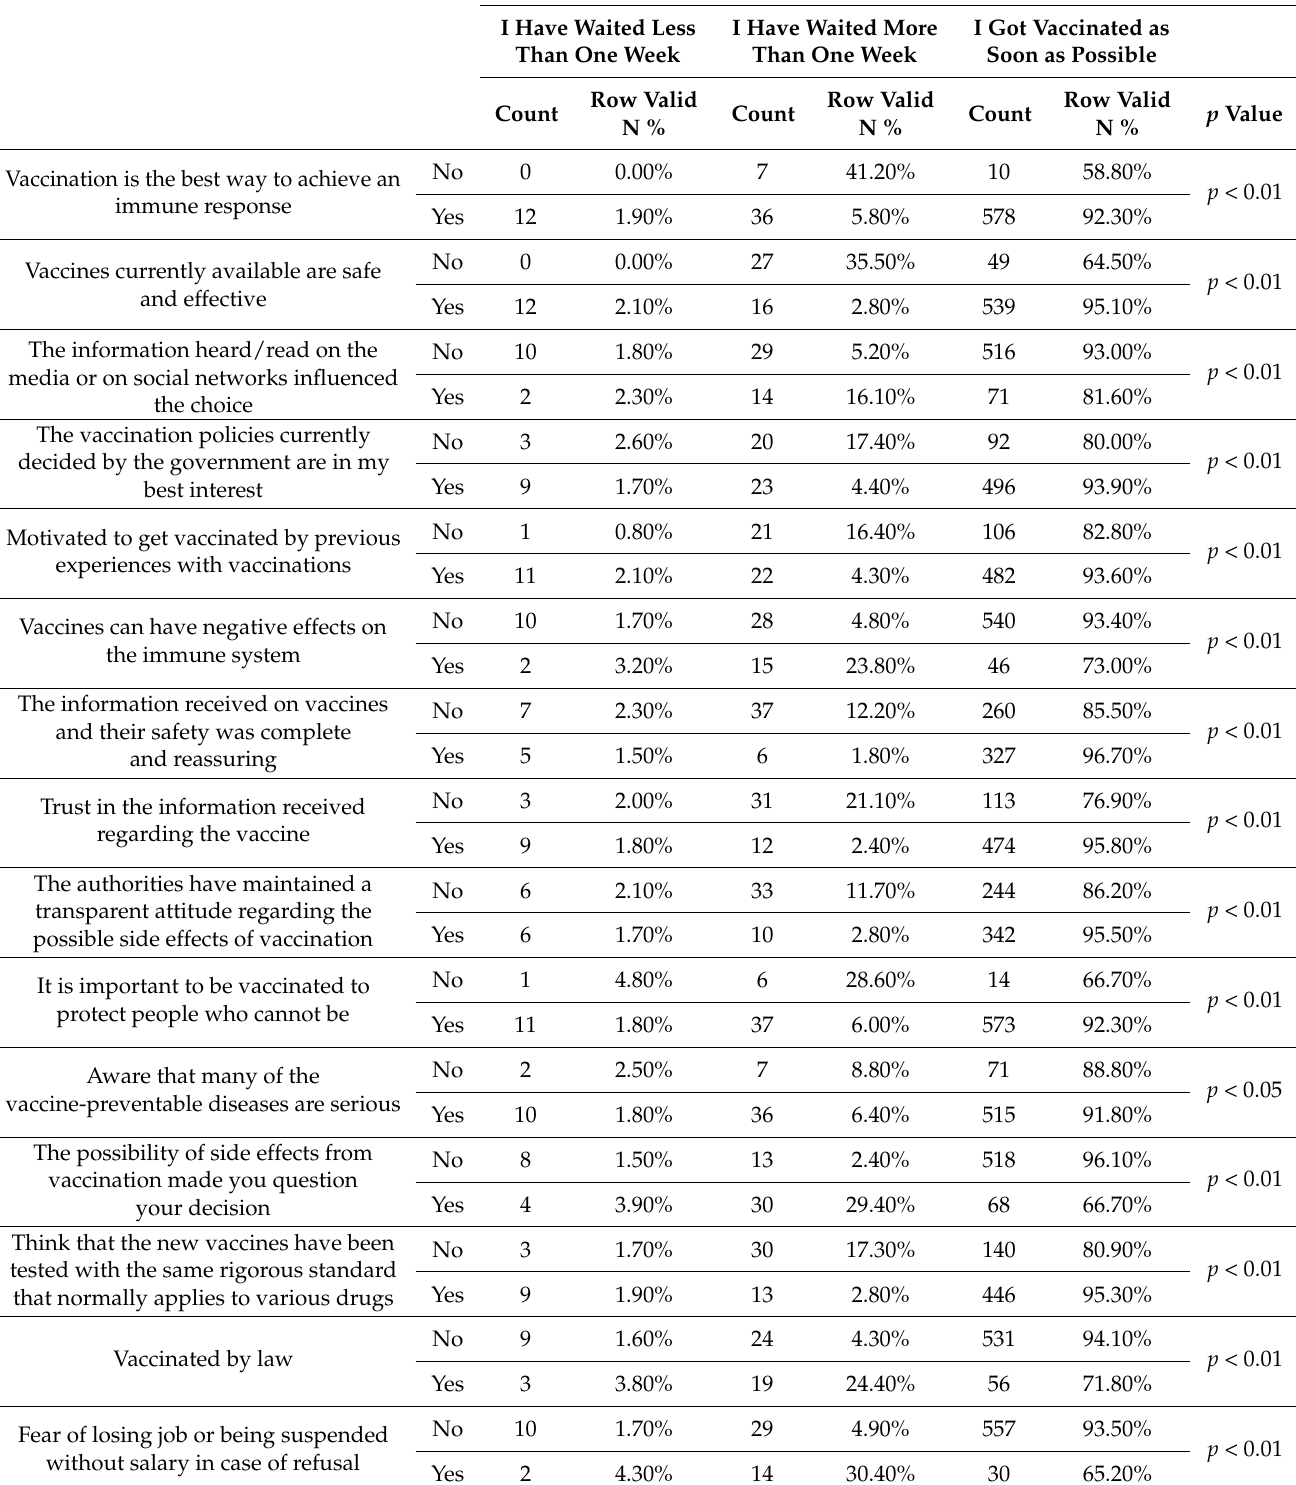
Table 1. Main results of the questionnaire on factors related to vaccine acceptance by different levels of hesitancy among the study